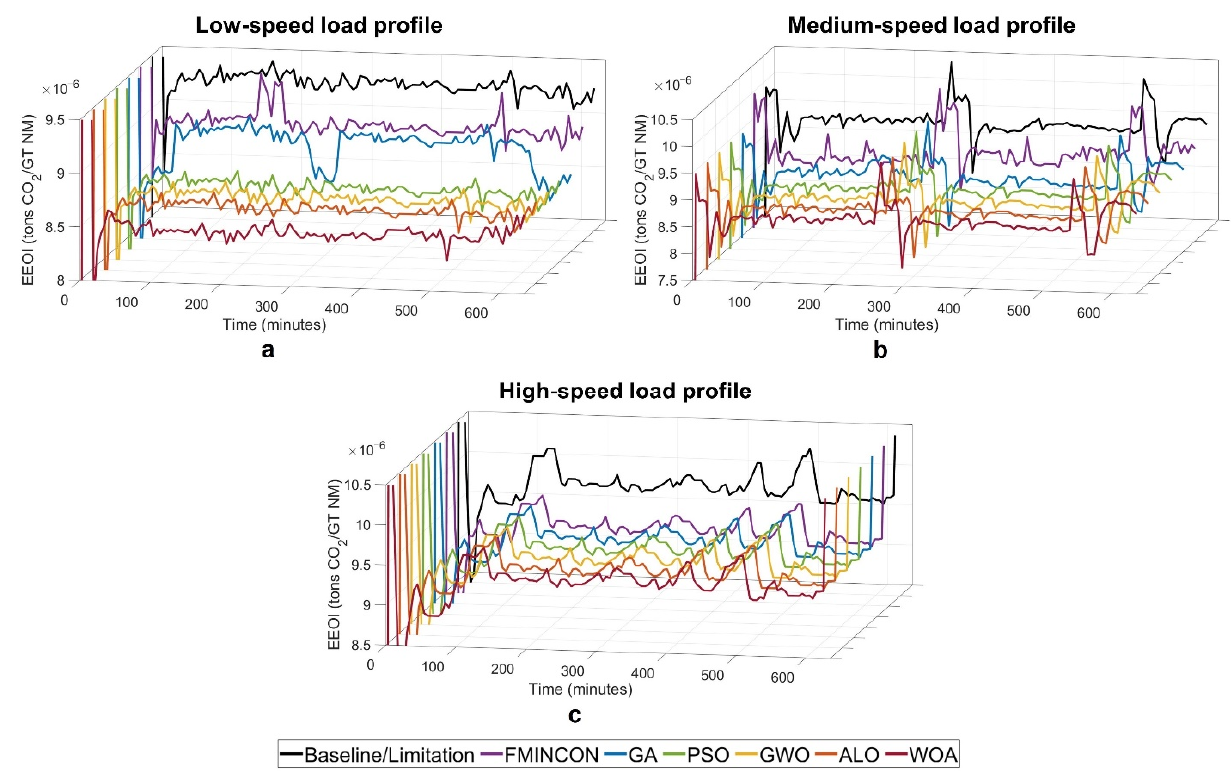
Figure 15. EEOI profiles of the 4-DG system for ( a ) low-speed profile ( b ) medium-speed profile ( c ) high-speed profile. Table 2. Average fuel-saving results of all